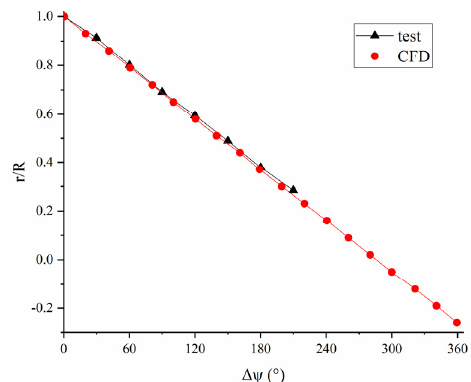
Figure 14. Horizontal (radial) displacements of the tip vortices with 𝜓 = 180°.